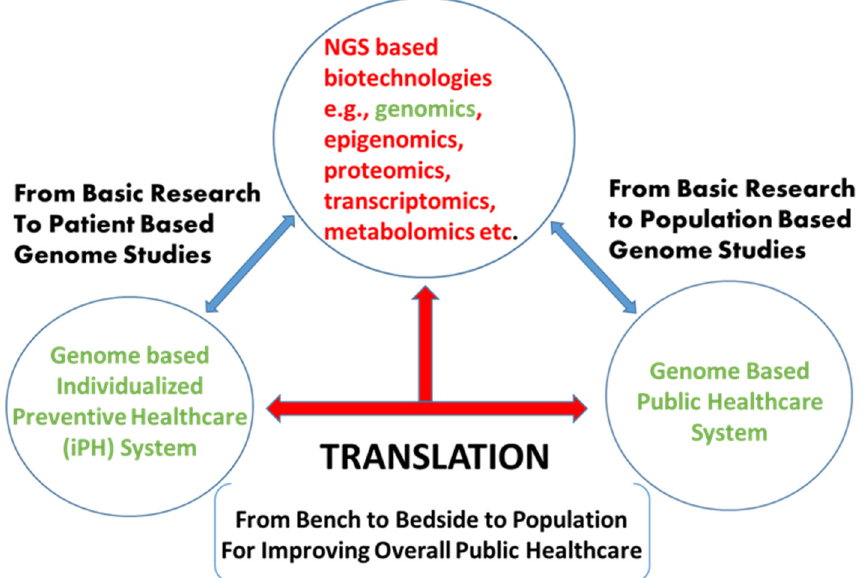
Figure 2. The schematic representation of next generation biotechnologies especially genome-based discoveries and their applications for patient and population-based studies for improving individualized, as well as the public, healthcare system.